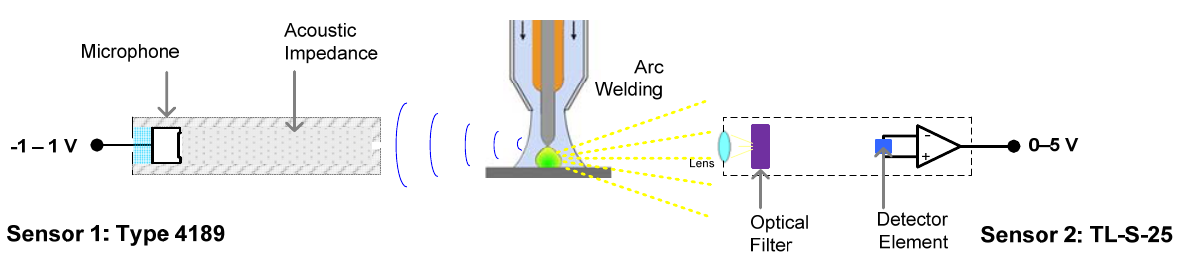
Figure 4. Competitive topology.